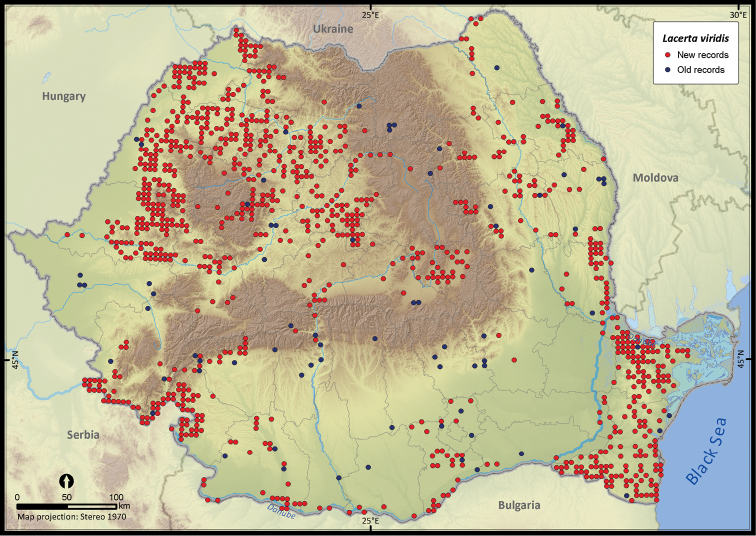
Lacerta viridis.